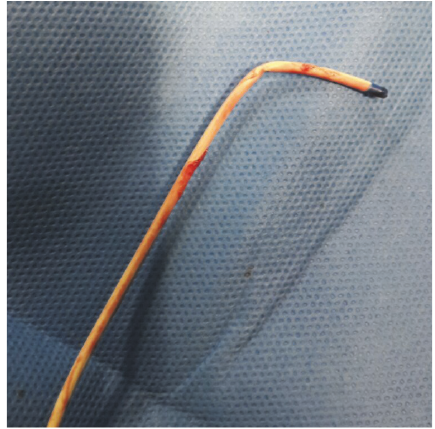
Figure 3: The bended